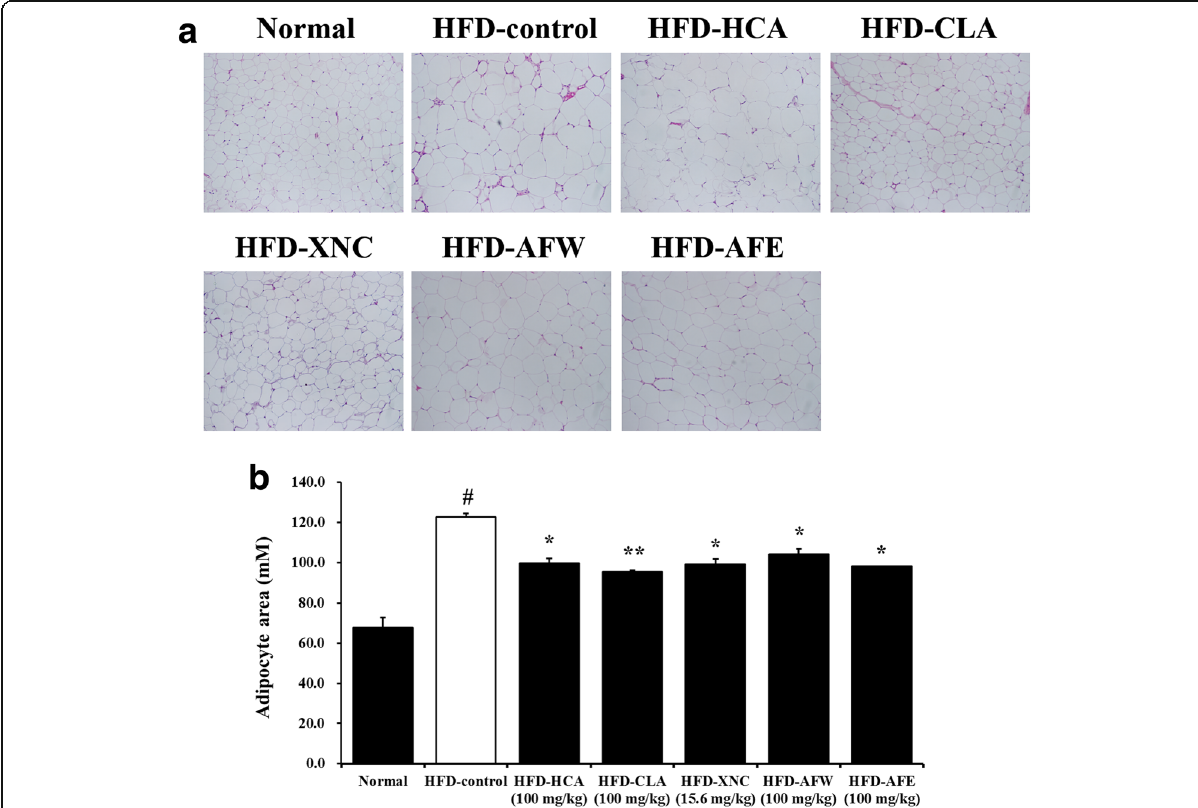
Fig. 6 Effect of 6-week treatment with Allium fistulosum aqueous extract (AFW) and A. fistulosum ethanolic extract (AFE) on adipocyte size in epididymal adipose tissue of high-fat diet (HFD)-induced obese mice. a Representative photographs of adipose tissue of hematoxylin and eosin-- stained tissue sections (magnification, 400×). b Adipocyte area of hematoxylin and eosin-stained adipose tissue sections. Normal, standard chow; HFD-control, HFD only; HFD-HCA, HFD plus 100 mg/kg Garcinia cambogia extract containing hydroxycitric acid; HFD-CLA, HFD plus 100 mg/kg conjugated linoleic acid; HFD-ORL, HFD plus 15.6 mg/kg Xenical (orlistat); HFD-AFW, HFD plus 100 mg/kg AFW; HFD-AFE, HFD plus 100 mg/kg AFE. Results are expressed as the mean ± standard error of the mean (SEM) ( n = 6). # p < 0.05 compared with the normal control group; * p < 0.05, ** p < 0.01 compared with the HFD-control